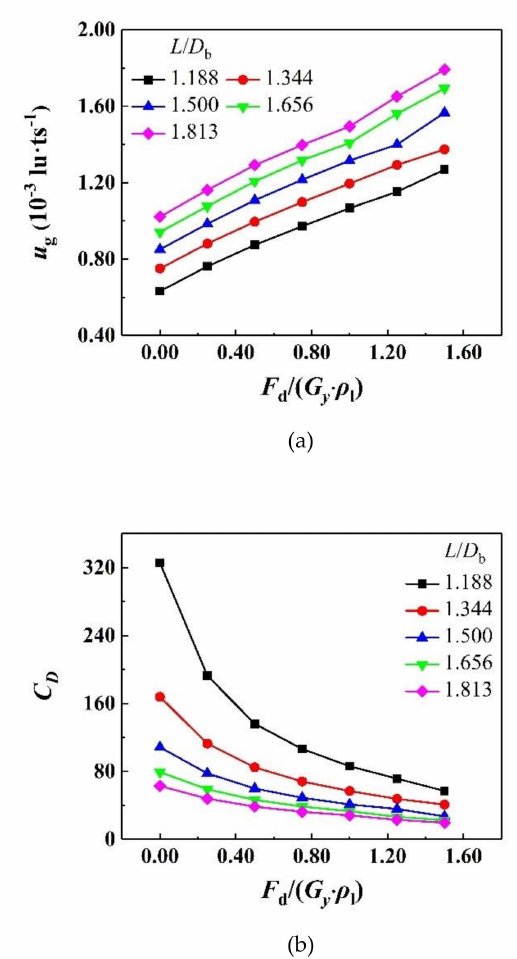
Figure 12. Variations of u g ( a ) and C D ( b ) with additional driving force at Re Gr = 100 and Eo =